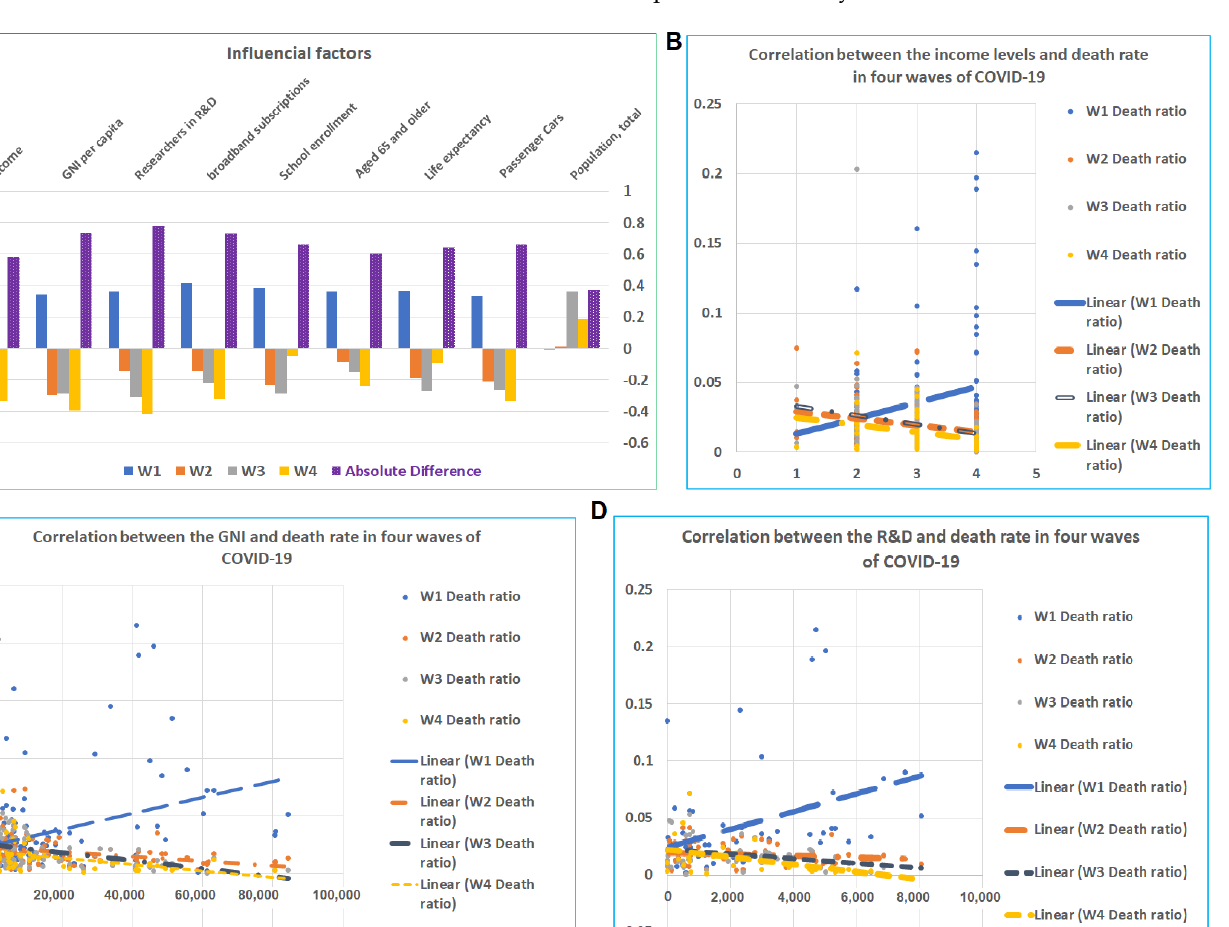
were further assessed in the first three waves which contain an adequate number CRs for analysis in groups at different income levels. Compared to the mortalities in wave 1, the reduction rate of the mortalities in waves 2 and 3 were significantly different among CRs at different income levels (Figure 3A). Among CRs at a high-income level, the mortalities in waves 2 and 3 were equal to 29% and 28% of that in wave 1, while in the upper-middle- income CRs, the rate was 76% and 79% for wave 2 and 3. The lower-middle-level CRs had rates of 88% and 90%, while among low-income levels, the rates were 135% and 135% (Figure 3B–E). Thus, the lower the income level, the slower the reduction rate in the mor- talities in the later waves of the disease.